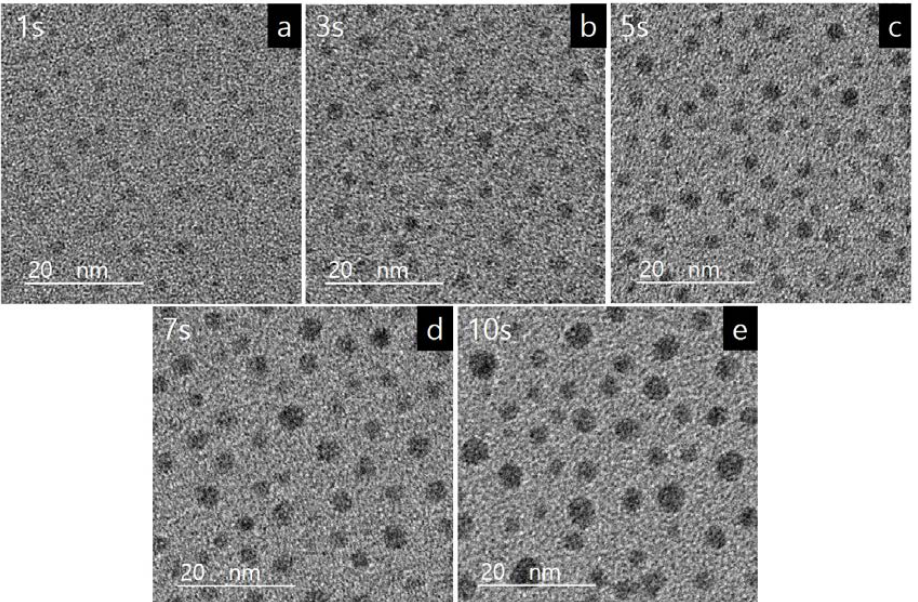
Figure 4. TEM images of Ag particles captured on an amorphous carbon membrane at the substrate bias of + 300 V for ( a ) 1 s; ( b ) 3 s; ( c ) 5 s; ( d ) 7 s; and ( e ) 10 s.